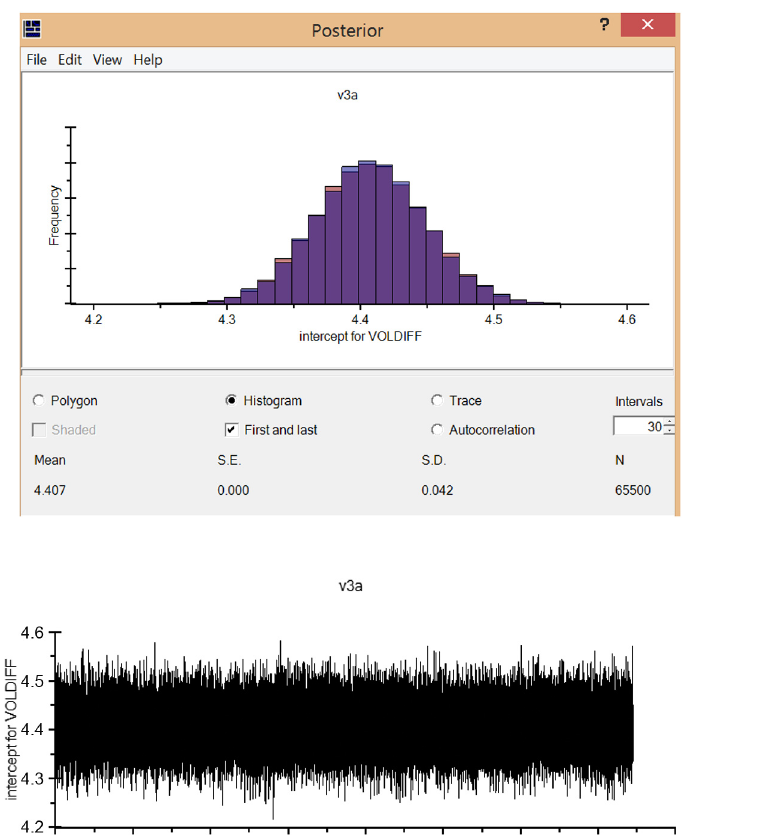
Figure 7. Bayesian SEM diagnostic trace plot for